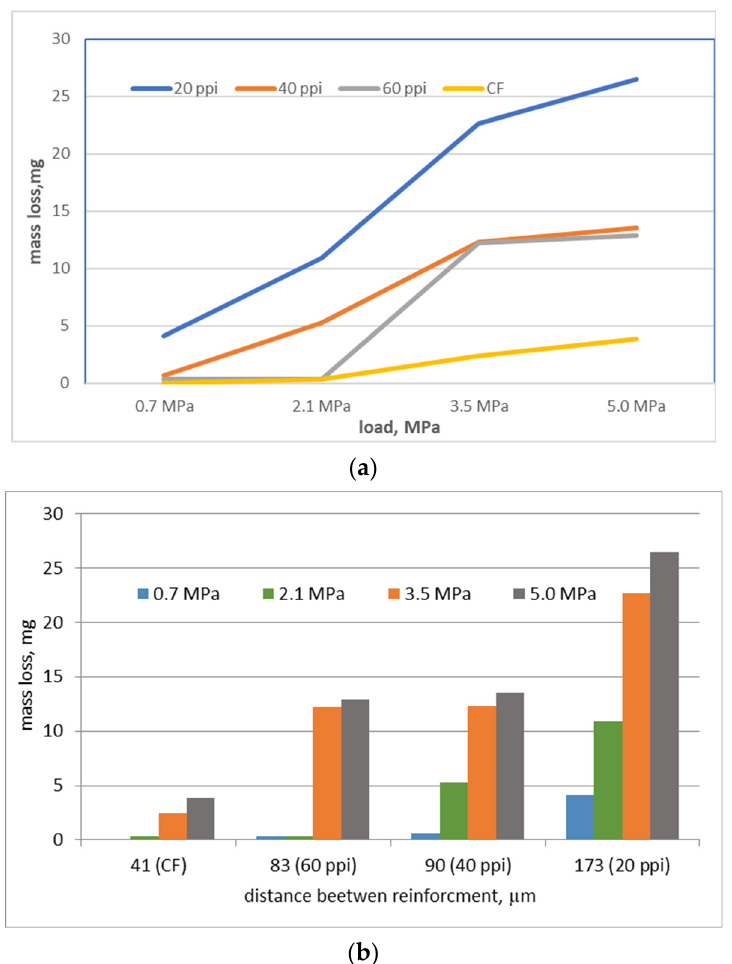
Figure 7. Correlation between mass loss vs. load ( a ) and mass loss vs. distance ( b ) between reinforcement carbon elements.